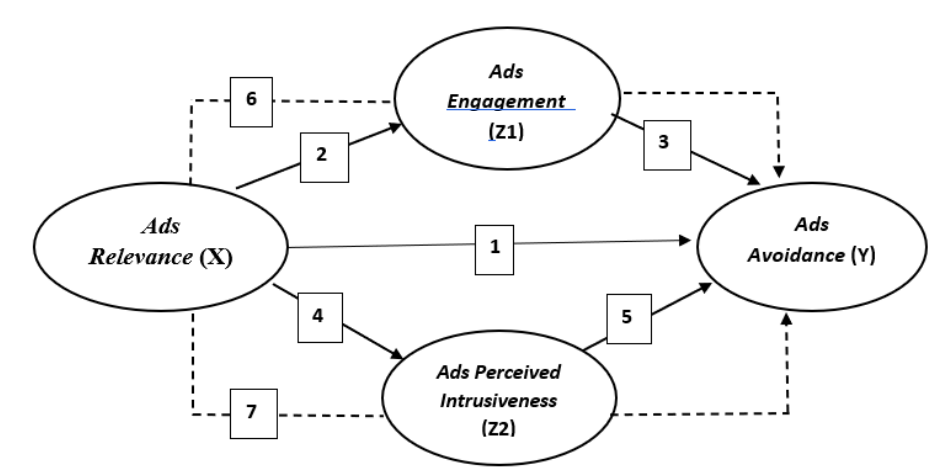
Figure 1: Research Framework and